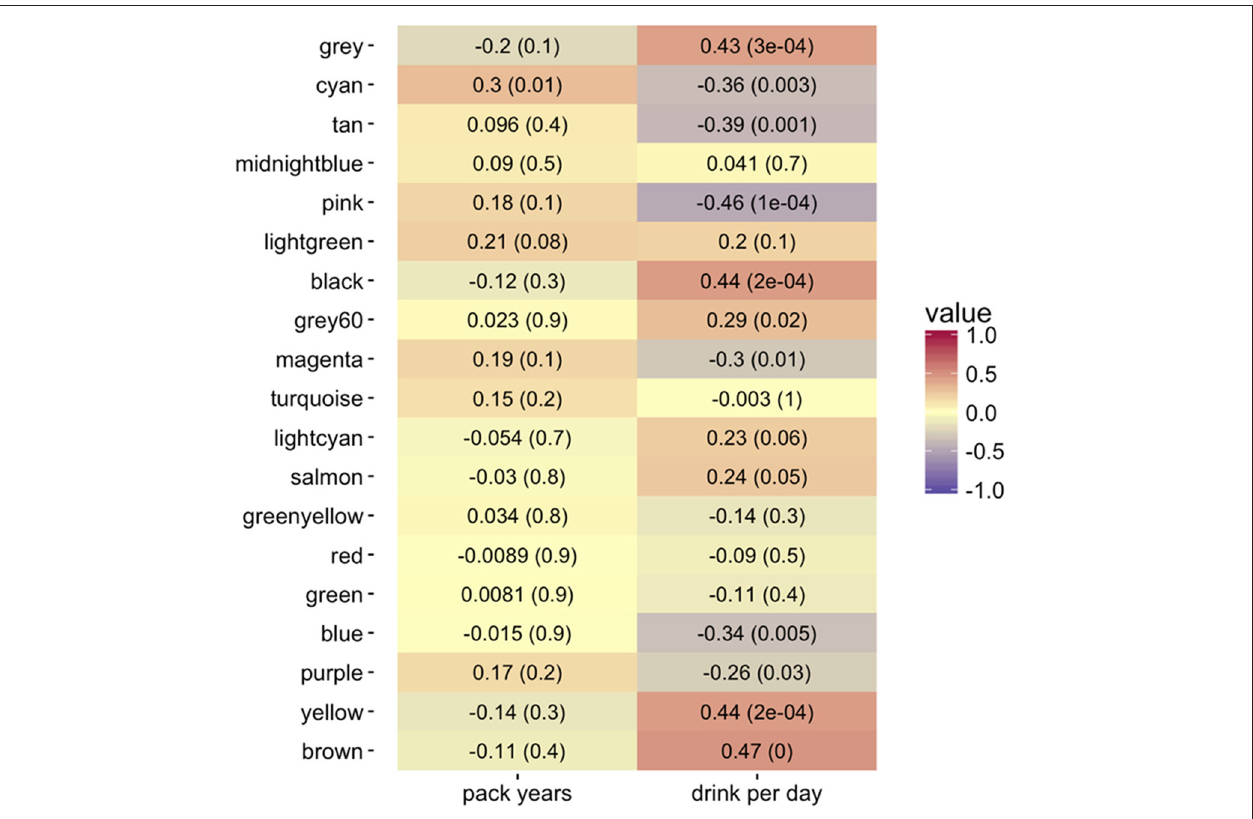
FIGURE 4 | Heatmap of Pearson correlations ( − 1:1 shown by color legend) for alcohol (drinks per day) and tobacco use (pack years) with the co-expression consensus module progressor eigengenes. The corresponding p -values are in parentheses. The brown, yellow, black, pink, tan, and cyan modules show the highest positive correlation with drinks per day. The cyan module shows the highest positive correlation with tobacco pack years smoked.